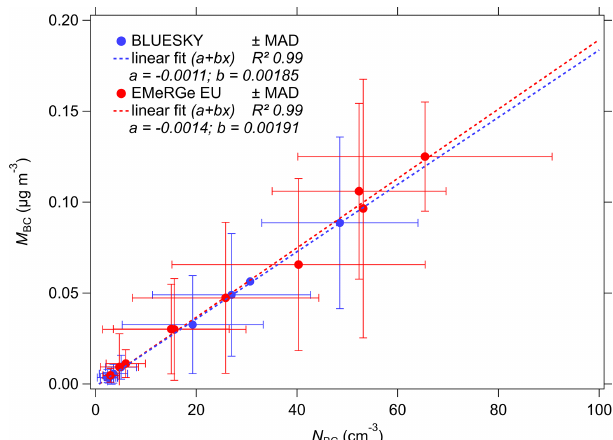
Figure 7. Scatter plot for data from vertical distribution of M BC and N BC . In red, data from 2017 collected during EMeRGeEU, in blue data from BLUESKY in 2020. Median absolute deviation (MAD) is shown as whiskers. Dashed lines are linear fits for each